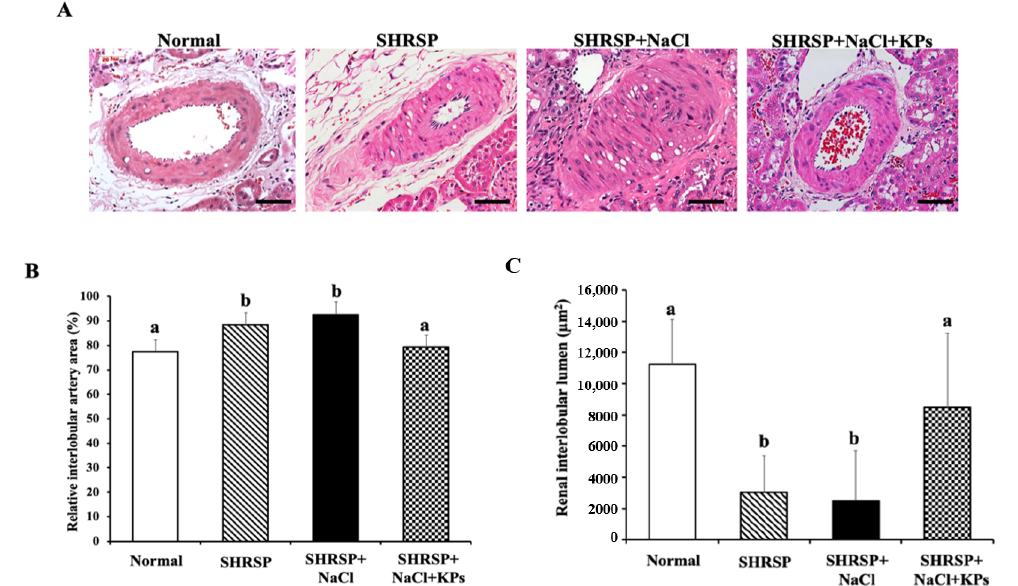
Figure 2. Morphological changes of the interlobular arteries in kidney tissues and quantitative total arterial thickness and lumen area. ( A ) WKY rats used as a normal control showed a normal morphology with a normal interlobular arterial thickness and lumen area. Interlobular arterial thickness was significantly elevated in the groups of SHRSP rats without (SHRSP) and with (SHRSP + NaCl) salt treatment compared to the WKY rats. The interlobular arterial thickness and lumen area in the SHRSP + NaCl + KPs group were examined by H&E staining at 400 × magnification; scale bar = 50 µ m. Three fields were imaged for each individual. ( B ) Interlobular arterial thickness (%) and ( C ) renal interlobular arterial lumen area ( µ m 2 ) in the kidney tissues were quantified with ImageJ analysis software. Data are presented as the means ± SEMs (Normal, n = 5; SHRSP, n = 5; SHRSP + NaCl, n = 6; SHRSP + NaCl + KPs, n = 6) and were analyzed by one-way ANOVA. Data within columns that are not labeled with the same letter are significantly di ff erent ( p < 0.05), as determined using Duncan’s